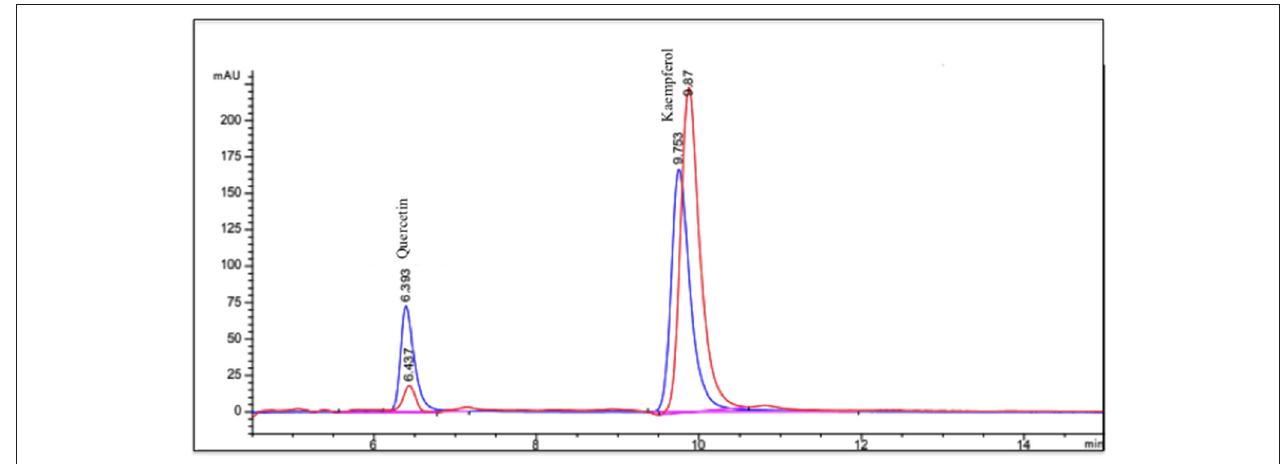
FIGURE 2 | HPLC profile of Chaya. Principal compounds in Chaya are quercetin (6.43min) and kaempferol (9.87min) (red line).